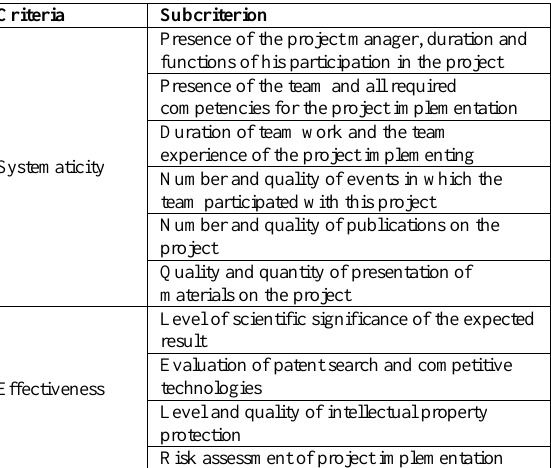
Table 1. Criteria for assessing the efficiency of scientific